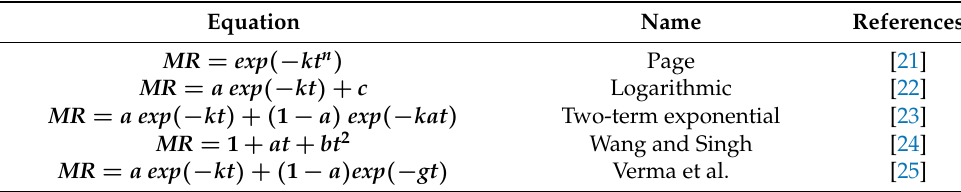
Table 1. Mathematical models used to fit experimental